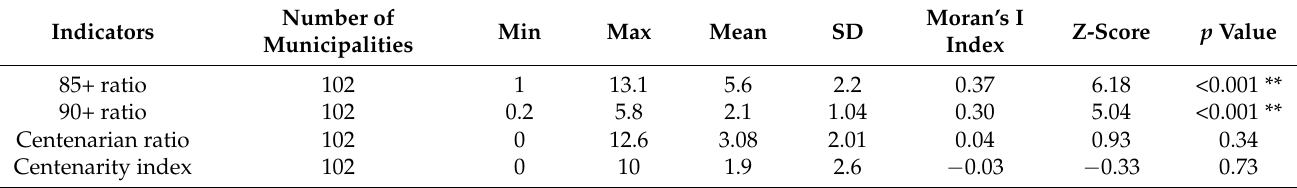
Table 1. Descriptive characteristics of longevity indicators among the 102 Cilento